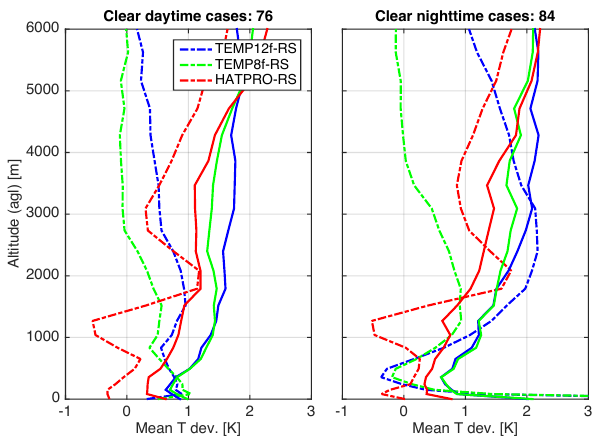
Figure 8. Mean (dashed-dotted lines) and standard temperature de- viation (solid lines) between HATPRO/TEMPERA radiometers and RSs during daytime (left) and night-time (right) under clear condi-